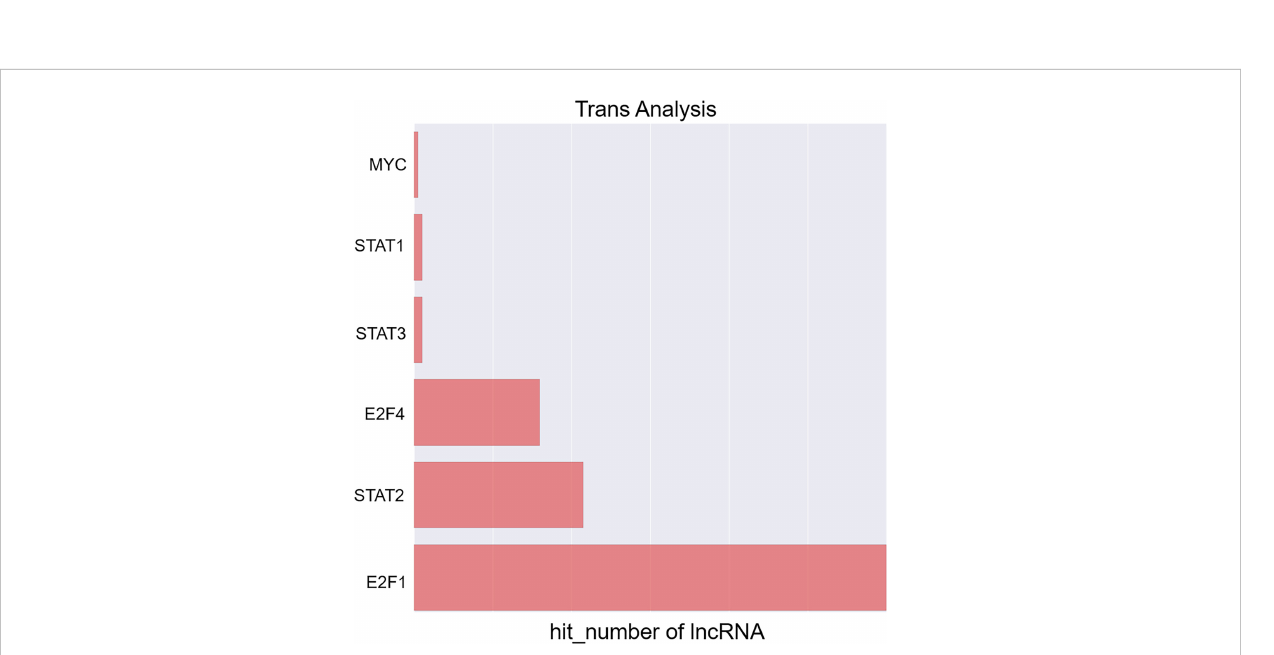
FIGURE 4 Pro fi ling of transcription factors associated with lncRNAs most signi fi cantly dysregulated between local advanced GC and early